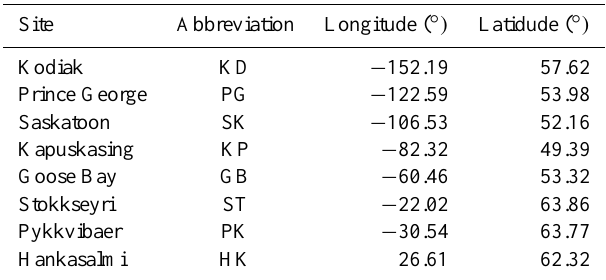
Table 1. The abbreviations and geographic coordinates of the